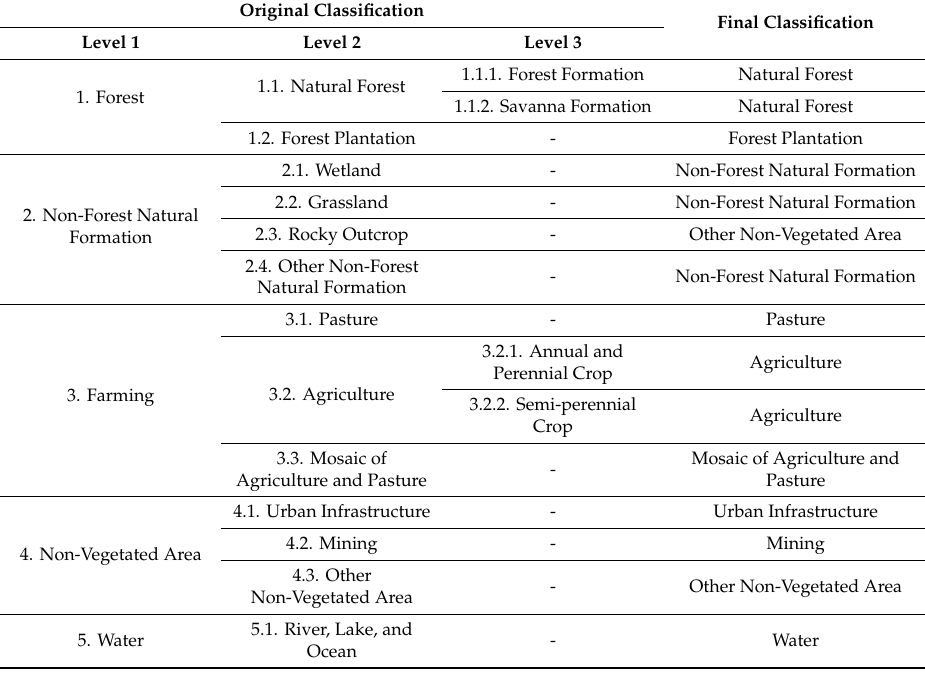
Table 2. Three-level hierarchy of land use and land cover categories in the 2001 and 2016 MapBiomas classification’). Only the categories present inside the study areas are included in the ‘Original Classification’